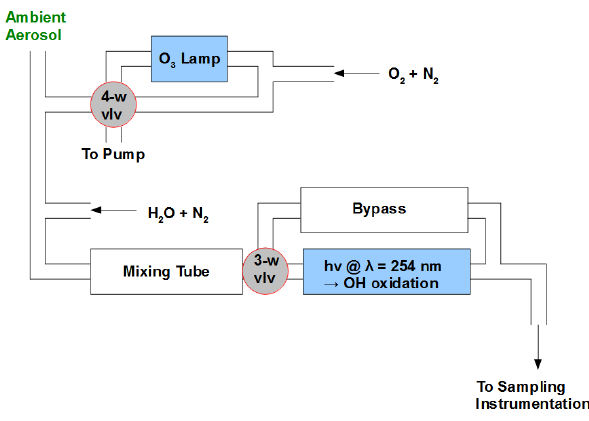
Fig. 1. Schematic diagram of the TPOT system. “4-w vlv” and “3-w vlv” denote the automatic 4-way and manual 3-way valves, respec-